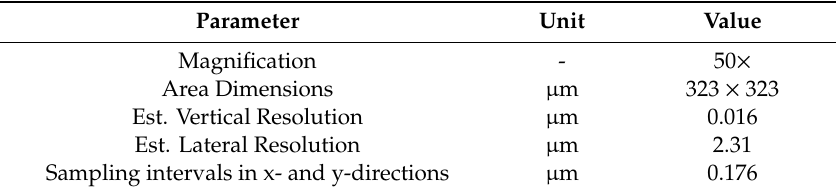
Table 4. Setup parameters of the focus variation